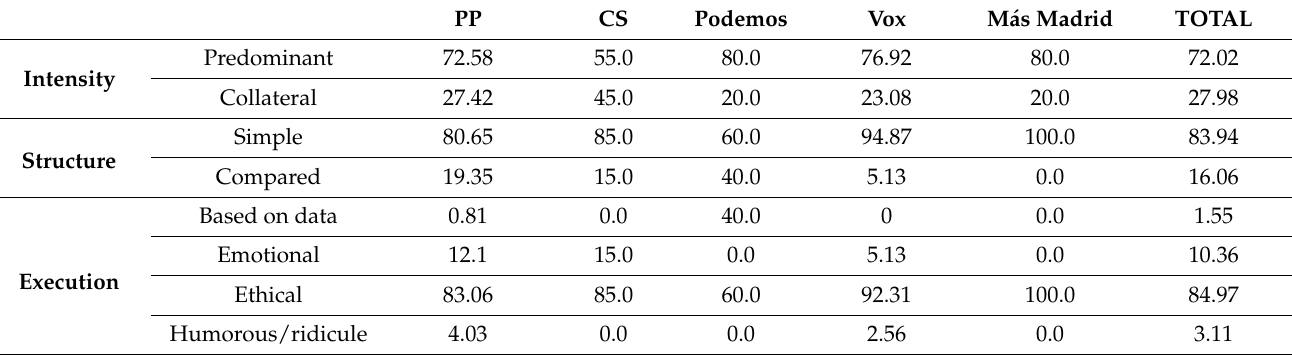
Table 4. How political parties criticize on Telegram (% within the